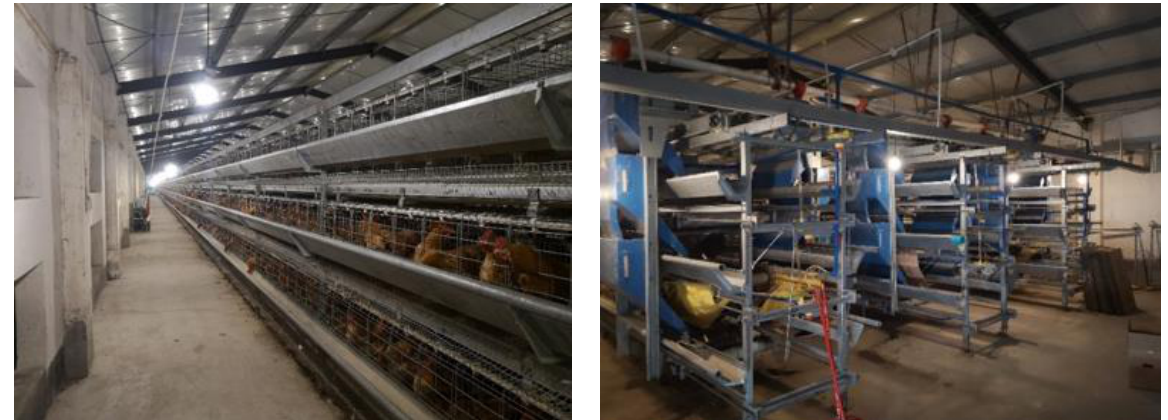
Figure 13. The poultry house of the signal strength and transmission rate test.